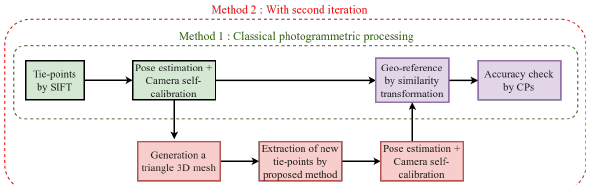
Figure 11. Two photogrammetric processing chains used in experiment.